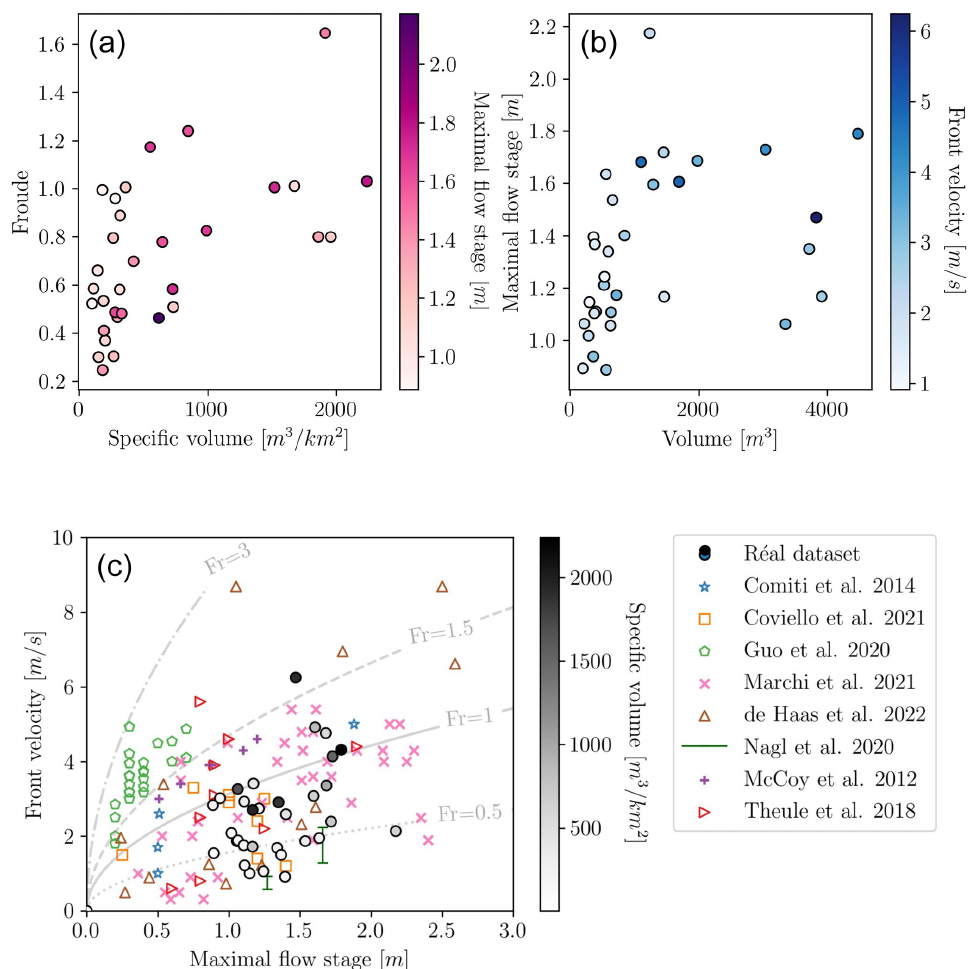
Figure 7. Examples of different relationships that can be explored with this dataset: (a) Froude number vs. specific surge volume, (b) maxi- mum flow height vs. surge volume and (c) front velocity vs. maximum methodology. Data from the literature (Comiti et al., 2014; Coviello et al., 2021; Guo et al., 2020; Marchi et al., 2020; de Haas et al., 2022; Nagl et al., 2020; McCoy et al., 2012; Theule et al., 2018) are displayed in panel (c) to contextualize the values. For Nagl et al. (2020), ranges of maximal and minimal values were taken. For Comiti et al. (2014) and Coviello et al. (2021), values of the flow height were estimated graphically. For Marchi et al. (2020), effective flow height was computed as the difference between flow height at the peak and the start of each surge. Colour mapping is only shown for the Réal dataset. Grey lines display different Froude number